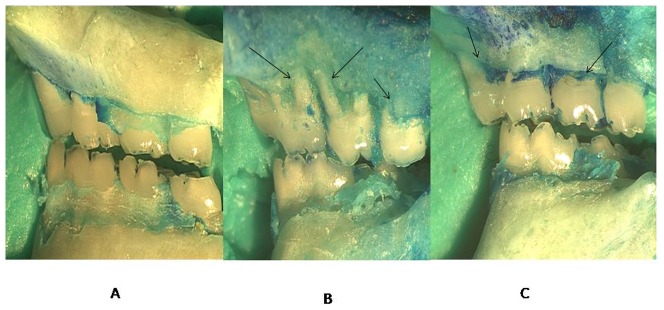
Clinical characteristics of teeth and periodontal tissue.(A) Samples from the NL group, with no resorption of the alveolar bone. (B) Samples from the L group, where severe bone resorption with root exposure is observed (Arrows). (C) Samples from the L group treated with Atorvastatin 10 mg/Kg, where decreased bone resorption is observed (Arrows). Images were obtained at an original magnification of 1.7×.